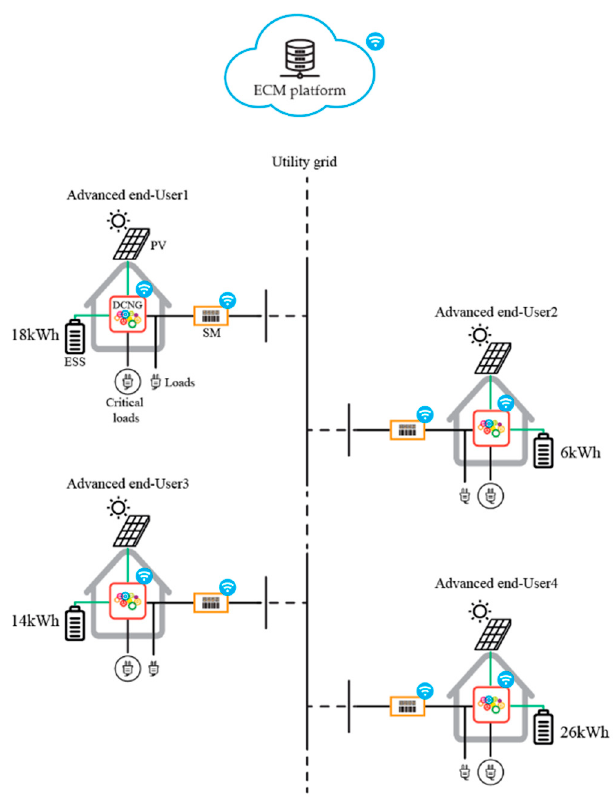
Figure 9. Community of four AEUs.